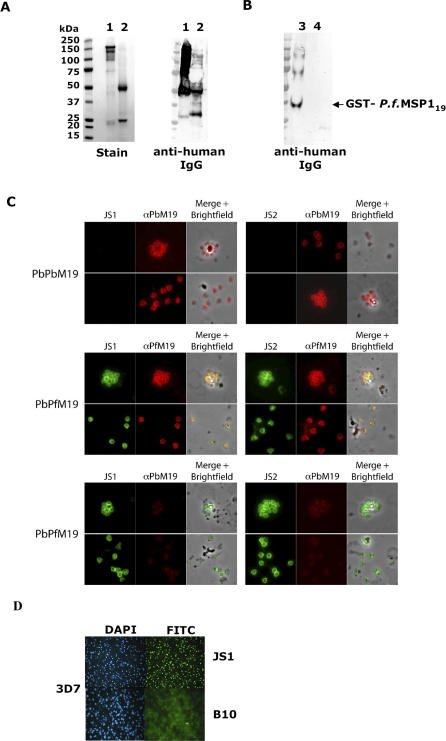
Characterization of Purified Abs(A) 5 μg purified anti-MSP119 human IgG1 (JS1) was subjected to SDS-PAGE under nonreducing (lane 1) or reducing (lane 2) conditions on 4%–15% polyacrylamide gradient gels and stained with Simply Blue or immunoblotted with anti-human IgG-HRP.(B) Under nonreducing conditions and after transfer to nitrocellulose, the human anti-MSP119 IgG1 (JS1) detects the recombinant GST-MSP119 fusion protein (lane 3) but not the GST alone control (lane 4). Localization of MSP119 by IFA.(C) Schizont- and merozoite-stage parasites from the transgenic PbPbM19 and PbPfM19 lines were incubated with human Abs JS1 or JS2 (1:100), rabbit αPbM19 (1:1,000), or αPfM19 (1:1,000). After incubation with goat anti-rabbit Alexa-conjugated Ig (1:1,000) and FITC-conjugated anti-human IgG Fc (1:200), slides were washed and mounted in Vectrashield anti-fade. Parasites were visualized by fluorescence microscopy ×100 magnification, with the same fields photographed using filters to detect Alexa and FITC.(D) JS1 reactive with MSP119 on methanol-acetone-fixed smears of merozoites and erythrocytes infected with P. falciparum (strain 3D7) ×40 magnification. JS2 gave similar results. No specific fluorescence was detected with an irrelevant human IgG1 (B10) recognizing MSP119 from P. yoelii [24].